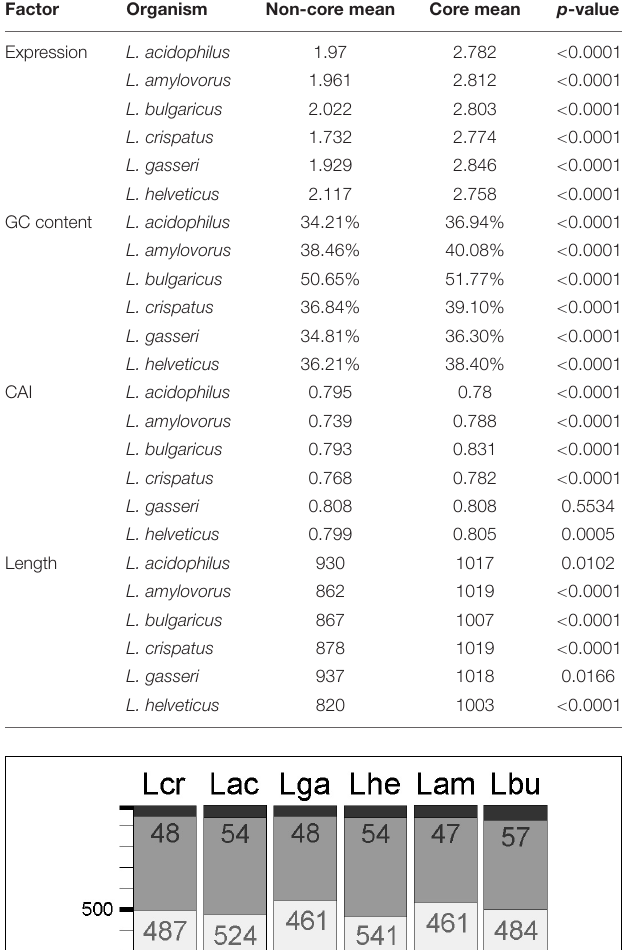
TABLE 2 | Statistical shift in core genome.